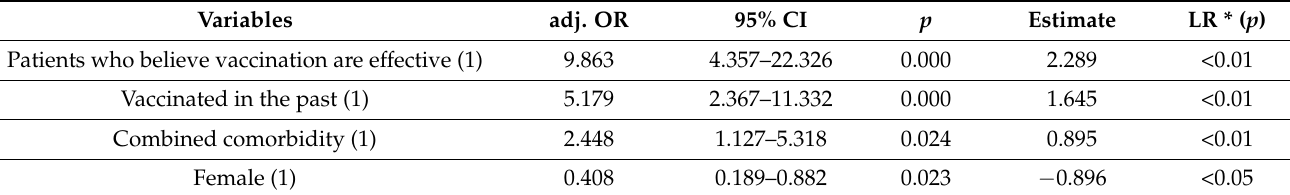
Table 4. Multivariate logistic regression.